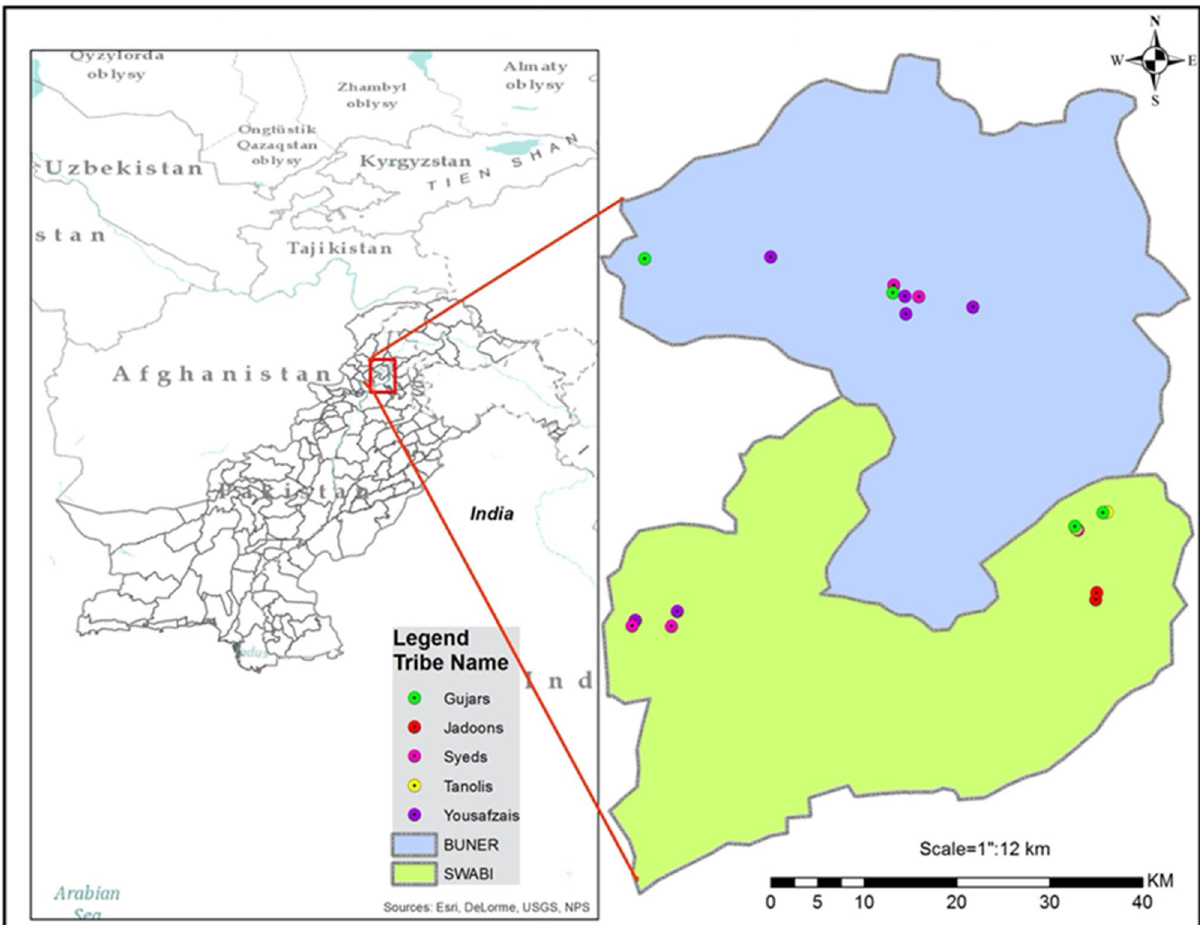
Figure 5. A map of Pakistan showing the locations of fieldwork in the Khyber Pakhtunkhwa Province. DNA samples were collected from areas in which each ethnic group was highly concentrated. Gujars, Syeds and Yousafzais were sampled from both Buner and Swabi Districts, while the Jadoons and Tanolis were only sampled in the Swabi District. The map was created with the ArcGIS software, v10.3.1., based on source map from ESRI https:// www. esri. com/ en- us/